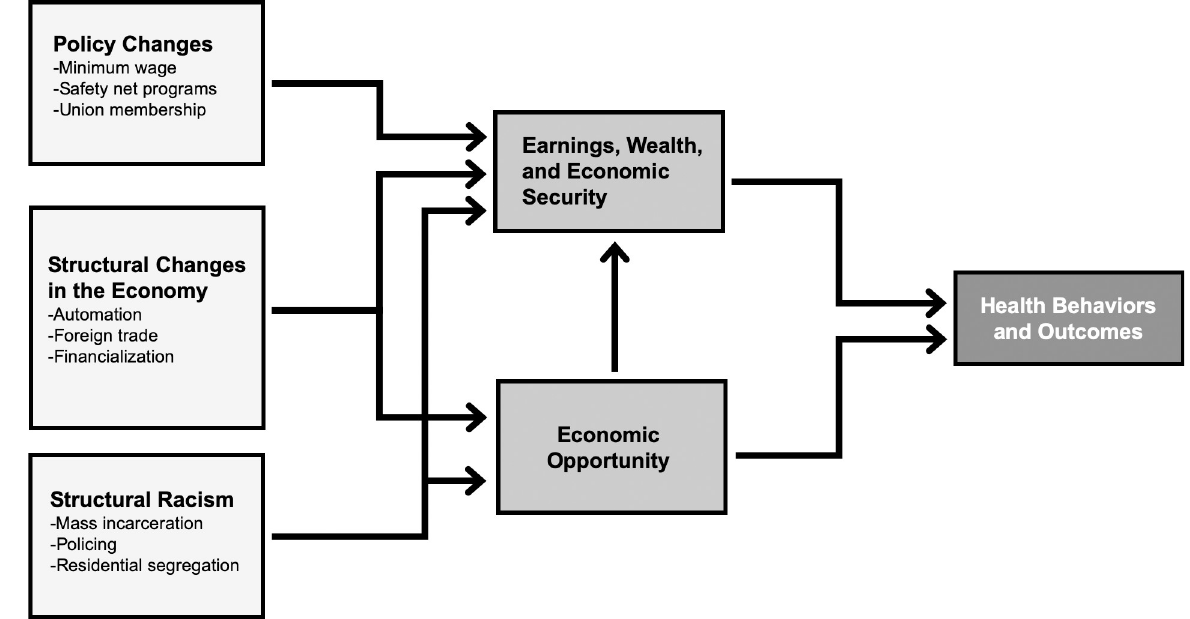
Fig 1. Drivers of economic outcomes and consequences for population health. Figure summarizes the key relationships between economic outcomes—and their underlying drivers—and health. To ensure better clarity, the figure only focuses on drivers and pathways discussed in this review. In doing so, we do not directly specify some relationships that are likely important for population health, e.g., direct effects of public policy (e.g., Medicaid expansions) and structural racism on health